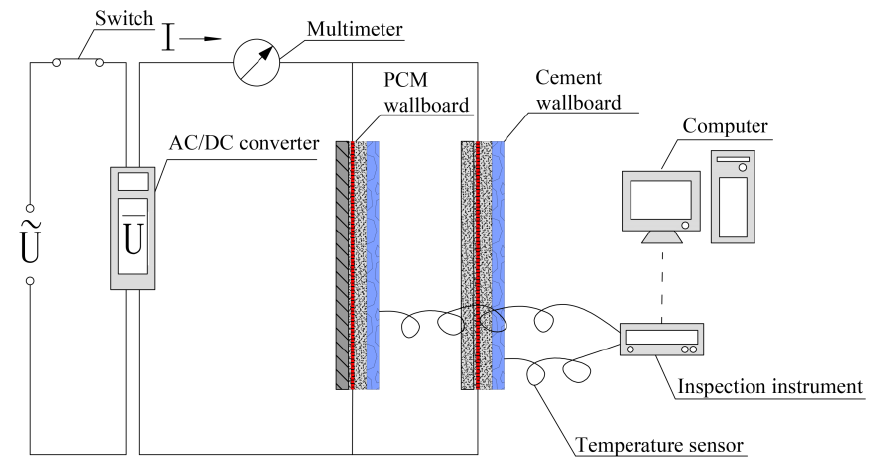
Figure 10. Schematic diagram of wallboard thermal performance test system.